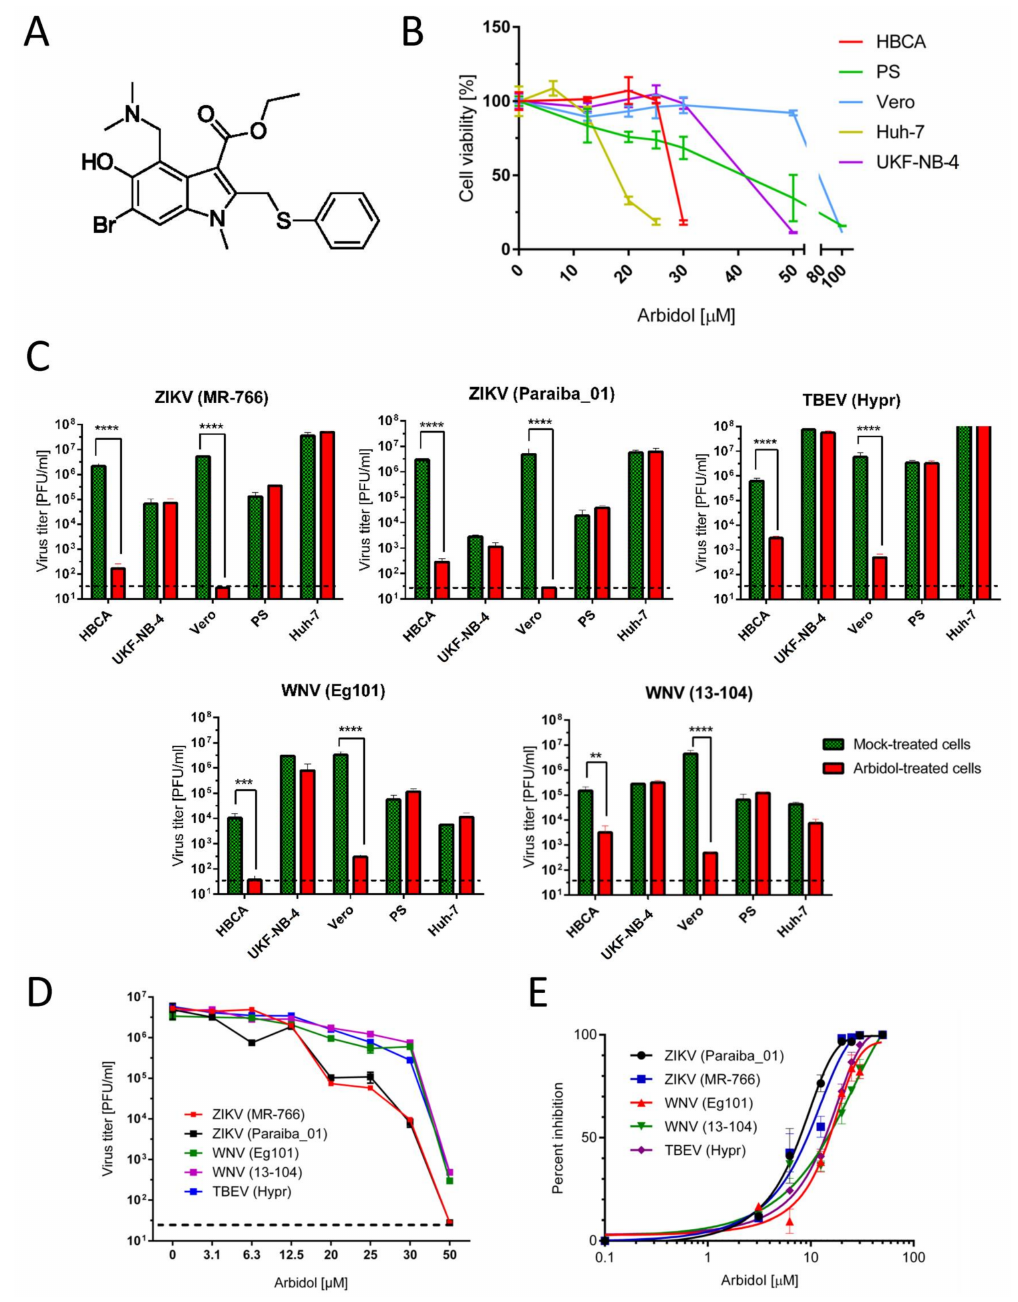
Figure 1. ( A ) Structure of arbidol. ( B ) Cytotoxicities of arbidol with Huh-7, PS, UKF-NB-4, HBCA, and Vero cells within the compound concentration ranges 0–100 µ M, 48 h post infection. ( C ) Antiviral effects of arbidol against ZIKV, WNV and TBEV infection in different cell lines. Given differential arbidol cytotoxicities with respect to different cell lines, indicated cell lines were treated with different maximum concentrations of arbidol (12.5 µ M for Huh-7, 25 µ M for HBCA and PS, 30 µ M for UKF-NB-4, and 50 µ M for Vero) 24 h prior to virus infection. Culture supernatants were then collected 48 h post infection and individual viral titers were determined by plaque assay. ( D ) Dose-dependent effects of arbidol on virus titers 48 h post infection in Vero cells. The horizontal dashed line indicates the minimum detectable threshold of 1.44 log 10 PFU/mL. ( E ) Inhibition of indicated flaviviruses in the presence of a serial dilution of arbidol. Data from two ( C ) or three ( B – E ) independent experiments done in triplicates. ** p < 0.01; *** p < 0.001; **** p <